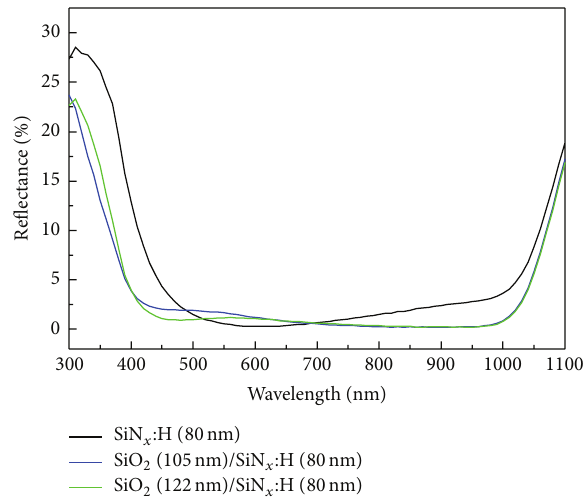
Figure 4: Reflectance curve for the single-layer ARC and double- layer ARC samples.